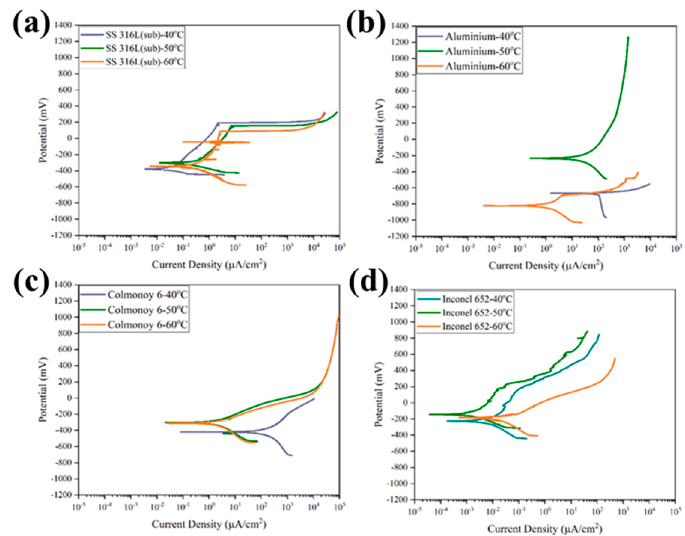
Figure 6. Polarization curves of ( a ) AISI 316 stainless steel, ( b ) Al, ( c ) Colmonoy, and ( d ) Inconel- coated samples.